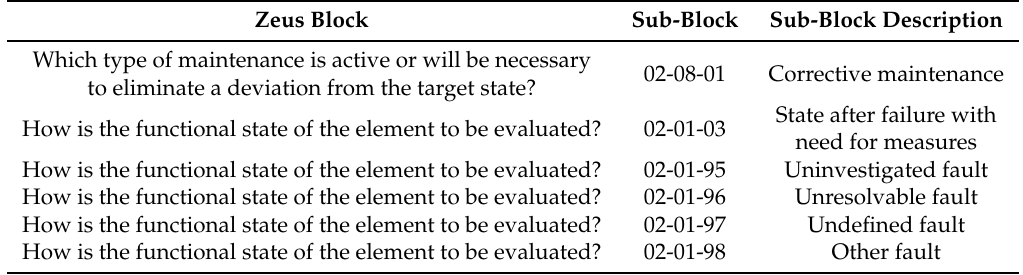
Table 5. Selection of events by ZEUS blocks.